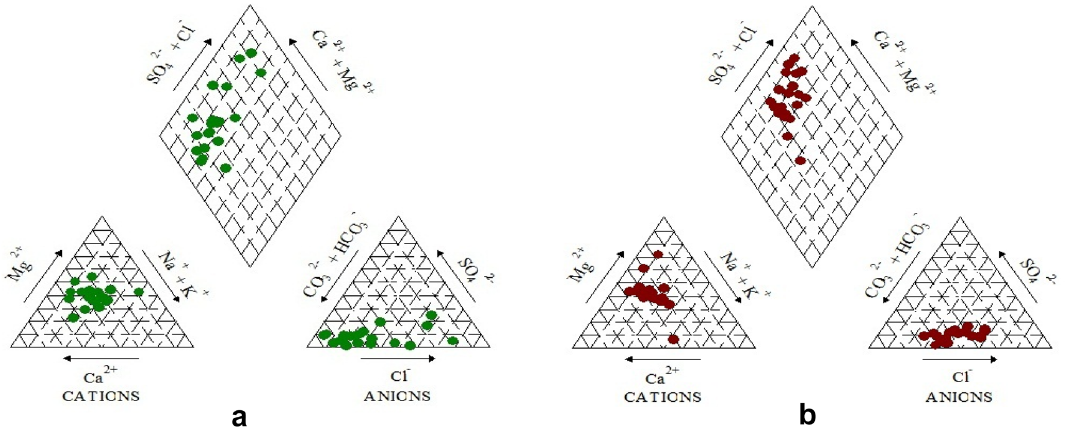
Fig. 12 Piper diagram. a Post monsoon, b pre